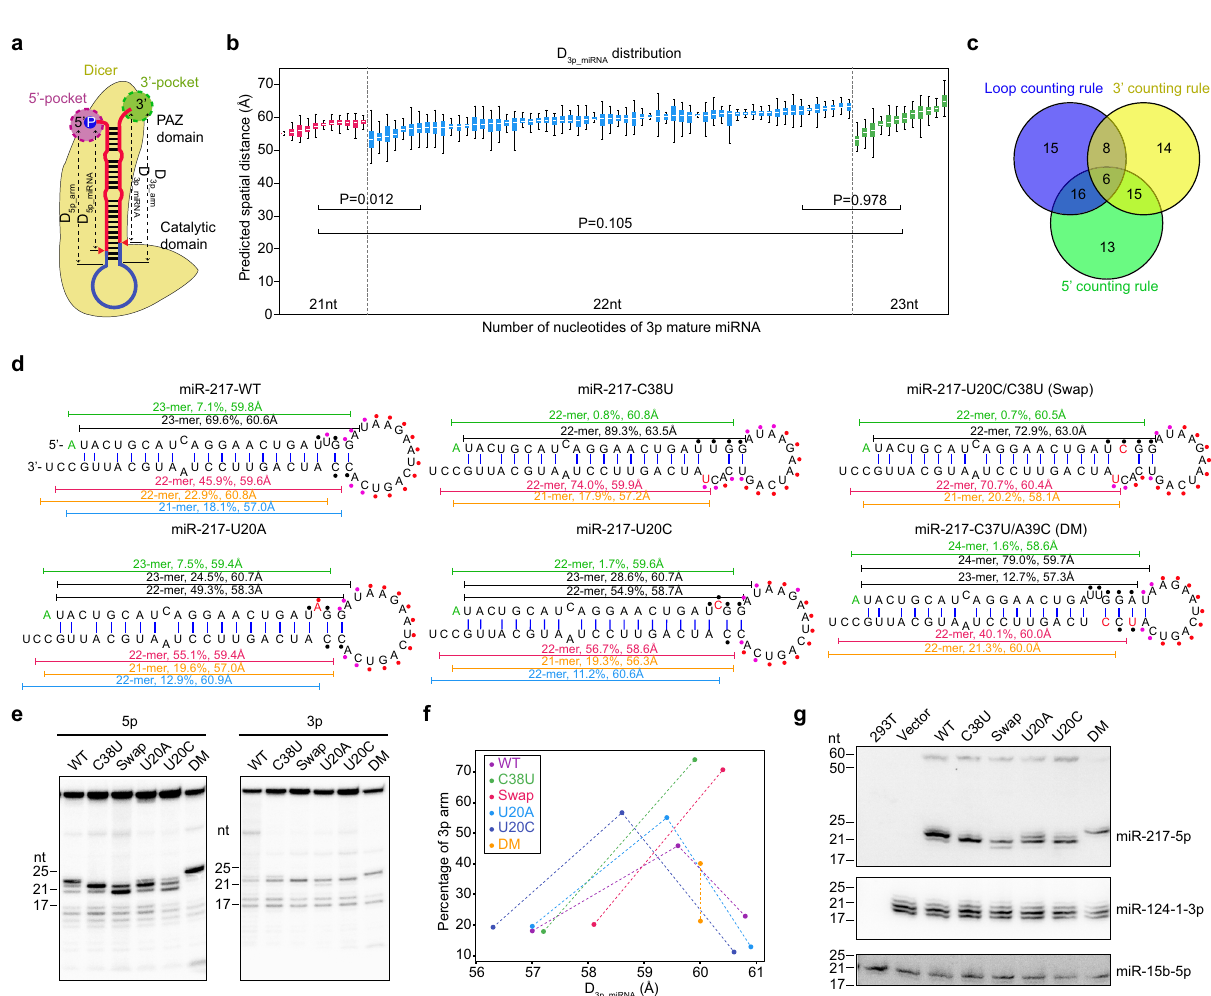
Fig. 4 Structure modeling reveals critical parameters for Dicer cleavage-site selection. a Cartoon shows the computational pipeline to calculate the spatial distance for mature miRNAs and their arms of pre-miRNAs. b Box plots of spatial distance between Dicer cleavage site on 3p arm of pre-miRNAs and their 3 ′ end. Each box represents the top 50 3D structures of each pre-miRNA predicted by the Rosetta software. Pre-miRNAs are divided into three groups with the number of annotated nucleotides in length with different colors. p Values were determined with a two-sided unpaired Student ’ s t test and were adjusted by their false discovery rate (FDR). Boxplots show the median (orange horizontal line), 25th and 75th percentiles (box edges), and 1.5-fold of the interquartile range (whiskers). c A Venn diagram shows all logical relations between different rules of Dicer cleavage-site selection on pre-miRNAs obtained by RIP-icSHAPE-MaP. d sRNA-Seq for ~20-nt long RNAs indicates a consistency for Dicer cleavage-site selection on 3p arms of pre-miR-217 variants, based on their spatial distance. The relative expression level and distance are shown for each isoform (shown as a blunt-ended line). The nucleotide substitutions on pre-miR217 variants are colored in red. The fi rst nucleotides which may correspond to 5 ′ end of pre-miR-217 isoforms are colored in green. Reactivity to NAI-N 3 , assessed by in vitro SHAPE analysis, are shown as colored dots for select nucleotides. The reactivity is de fi ned as the ratio of darkness quanti fi ed by Image J between the NAI-N 3 ( − ) and NAI-N 3 ( + ) sample of the gel. High reactivity (ratio > 1.6), medium reactivity (1.2 < ratio ≤ 1.6) or low reactivity (ratio ≤ 1.2) are denoted as red, orange or black points. e In vitro Dicing assay con fi rms Dicer ’ s direct role on cleavage-site selection shown in panel ( d ). The experiment was repeated three times with similar results. f Scatter plot indicating that the isoforms having D 3p_miRNA closer to 59 Å will yield relatively higher expression, compared to their counterparts outside this distance range. g sRNA northern blots showing the heterogeneity in the lengths of the miR-217-5p isoforms. mmu-miR-124-1-3p and has-miR-15b-5p were used to show approximately equal loading. The experiment was repeated three times with similar results. Source data are provided as a Source Data fi